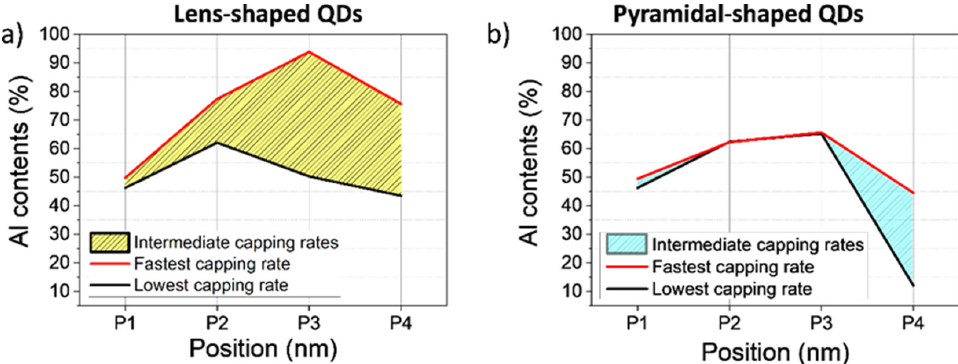
Figure 9. Al contents in the CL for lenticular ( a ) and truncated pyramid QDs ( b ) in the positions marked in Figure 7. (P1) corresponds to regions of the WL away from the QD, (P2) at the QD edge, (P3) close to the QD top and (P4) above the QD.